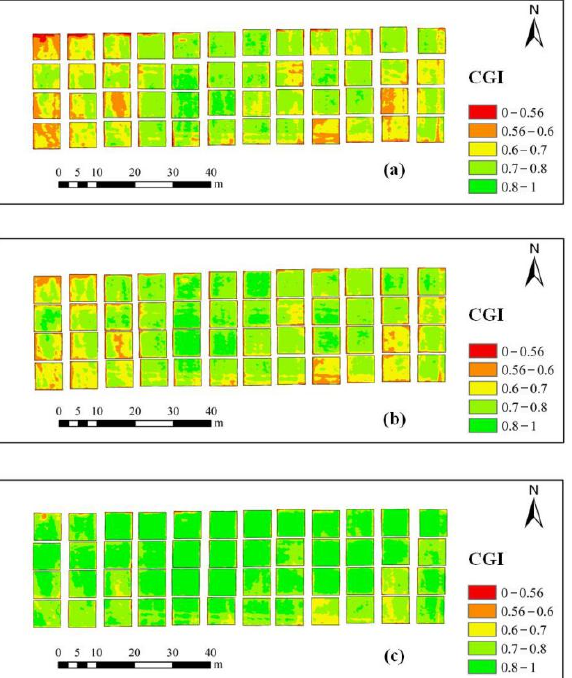
Figure 6. Map of CGI distribution based on UAV hyperspectral images: ( a ) (GS 31); ( b ) (GS 47); ( c ) (GS 65). From jointing to flowering, the average RGB-based CGI ranges from 0.74 to 0.79 (Figure 5) and hyperspectral-based CGI averages from 0.74 to 0.78 (Figure 6). In